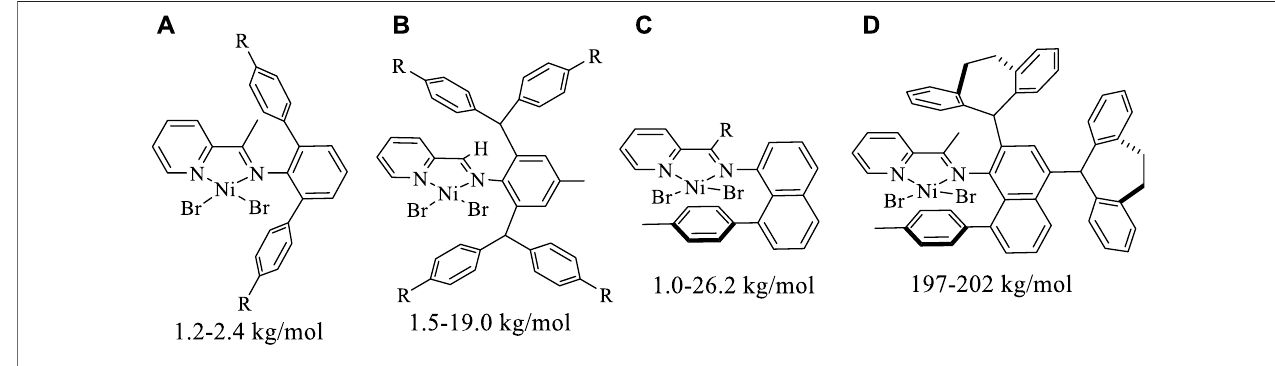
FIGURE 5 | Comparisons on molecular weights of polyethylene yielded with previously reported nickel catalysts (A – C) and Ni5 (D) .